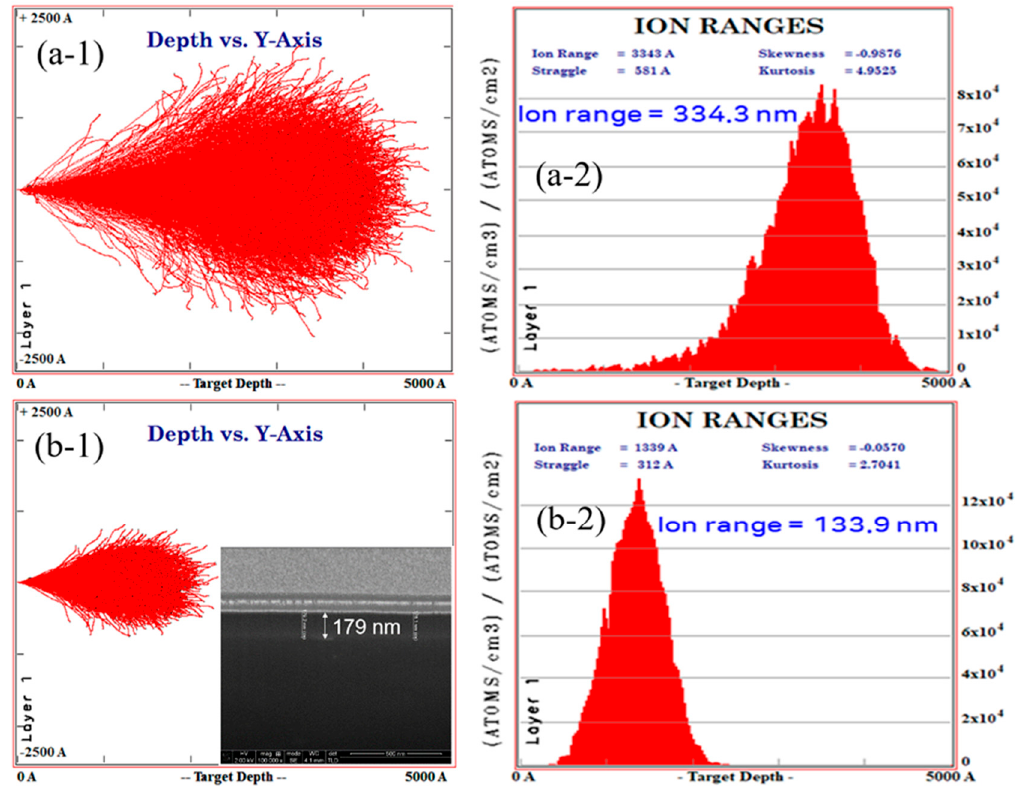
Figure 7. ( a-1 , a-2 ) Nitrogen and ( b-1 , b-2 ) chromium ion beams irradiation by SRIM simulation result.